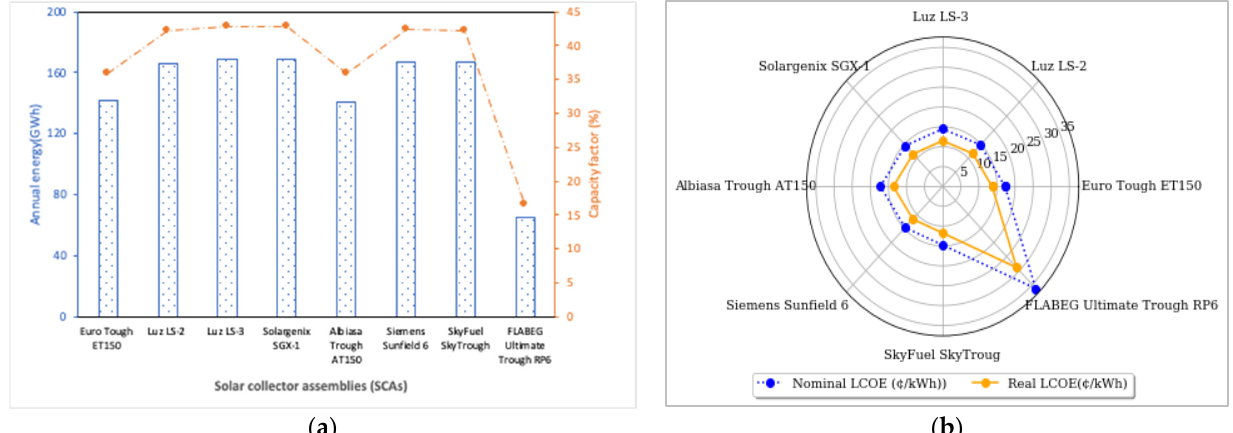
Figure 4 . Comparison of ( a ) output power and capacity factor and ( b ) nominal and real LCOE for PTC plant with different types of collectors .